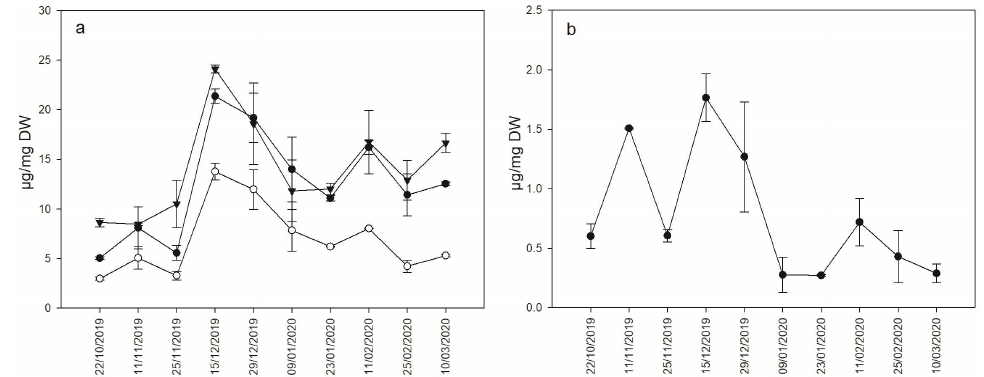
Figure 1. ( a ) Accumulation dynamics of fructose, glucose and sucrose in buds of UD 31-103 through- out the 2019–2020 winter season. In ( b ), the raffinose accumulation pattern in the same samples is reported. Results are expressed as the mean of 3 biological replicates of 10 buds ± standard error. Statistical analysis is provided in Supplementary Table